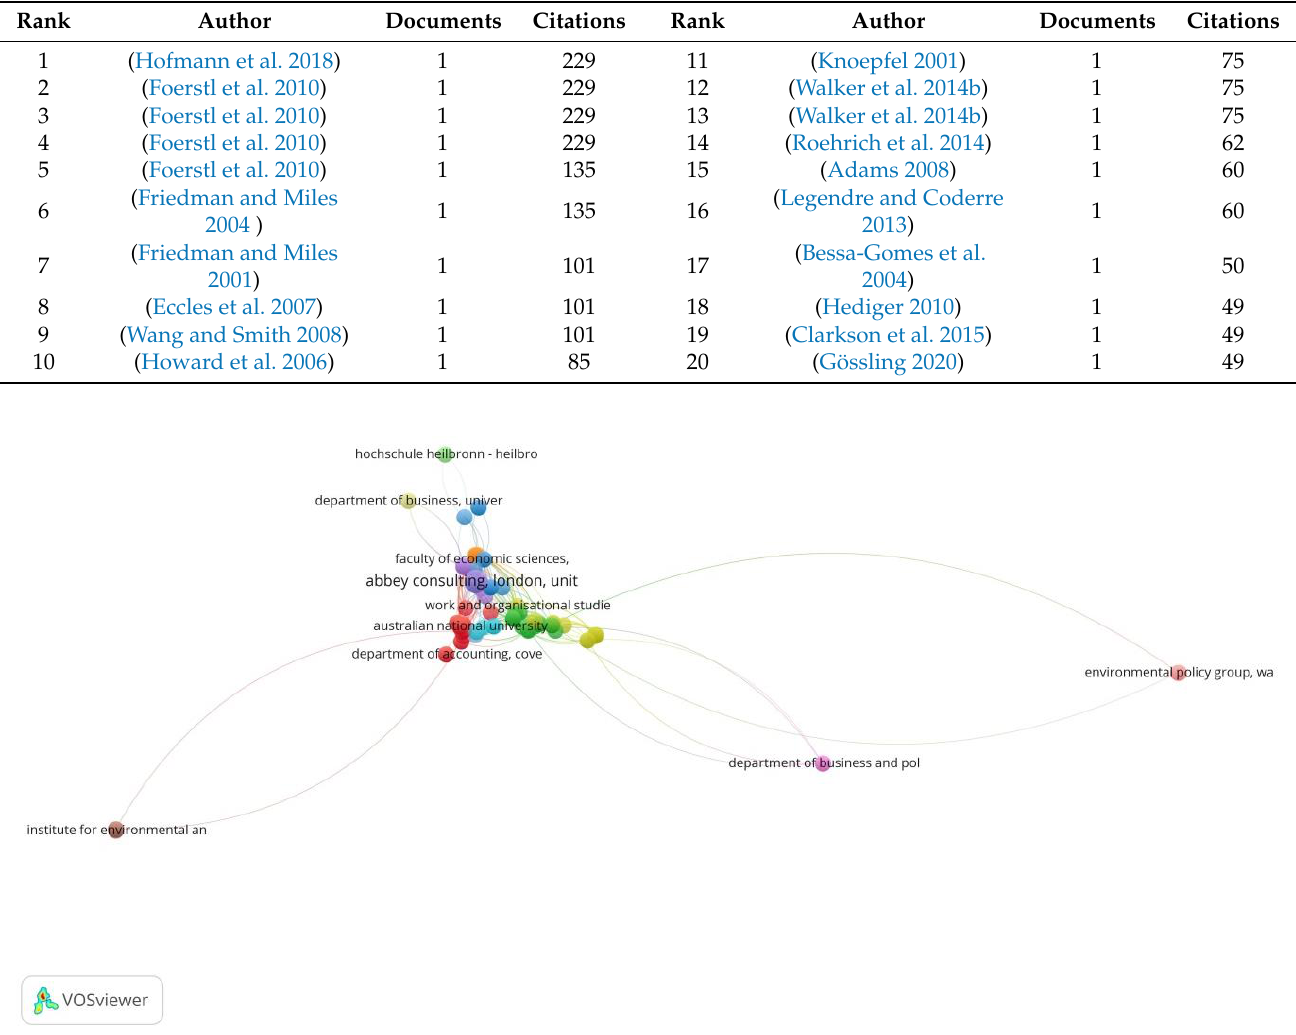
Figure 6. Searched keywords.